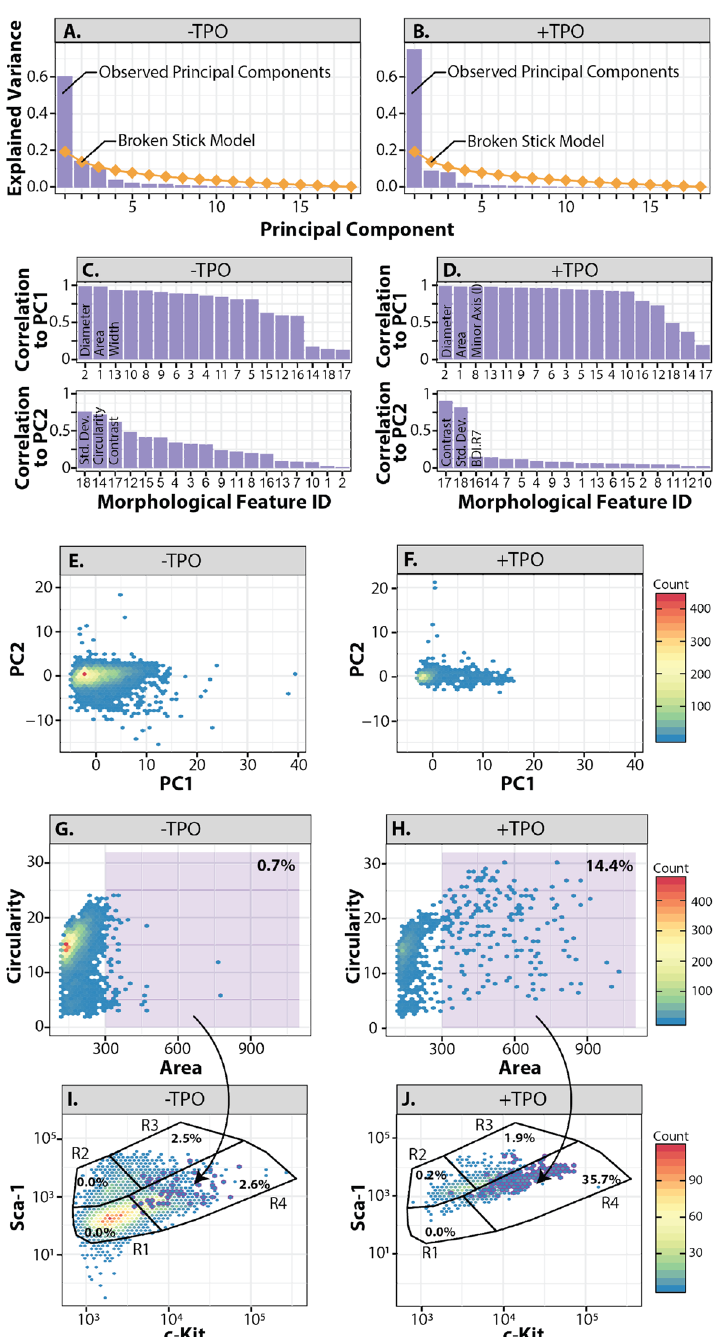
Figure 3. Morphology predicts MKRP phenotype using PCA. ( A,B ) Scree plots showing percent eigenvalue for each principal component in the LSK morphology dataset in the ( A ) − TPO and the ( B ) + TPO conditions. The theoretical percent variation under the broken-stick model is represented as a diamond dashed line, which indicates the boundary between interpretable and uninterpretable principal components. ( C,D ) The absolute contribution/correlation of each morphological feature to each morphological principal component in the ( C ) − TPO and ( D ) + TPO conditions. ( E,F ) Projections of LSK cells grown in the ( E ) −TPO and ( F ) + TPO conditions on the space defined by the first and second principal components. ( G,H ) Cell area vs. circularity of LSK cells in the ( G ) − TPO and the ( H ) + TPO conditions. A gate is included (shaded purple) to mark particularly large and circular cells with the percent of cells present in each gate. ( I,J ) PCA data mapped back onto the experimental flow data in the ( I ) − TPO and ( J ) + TPO